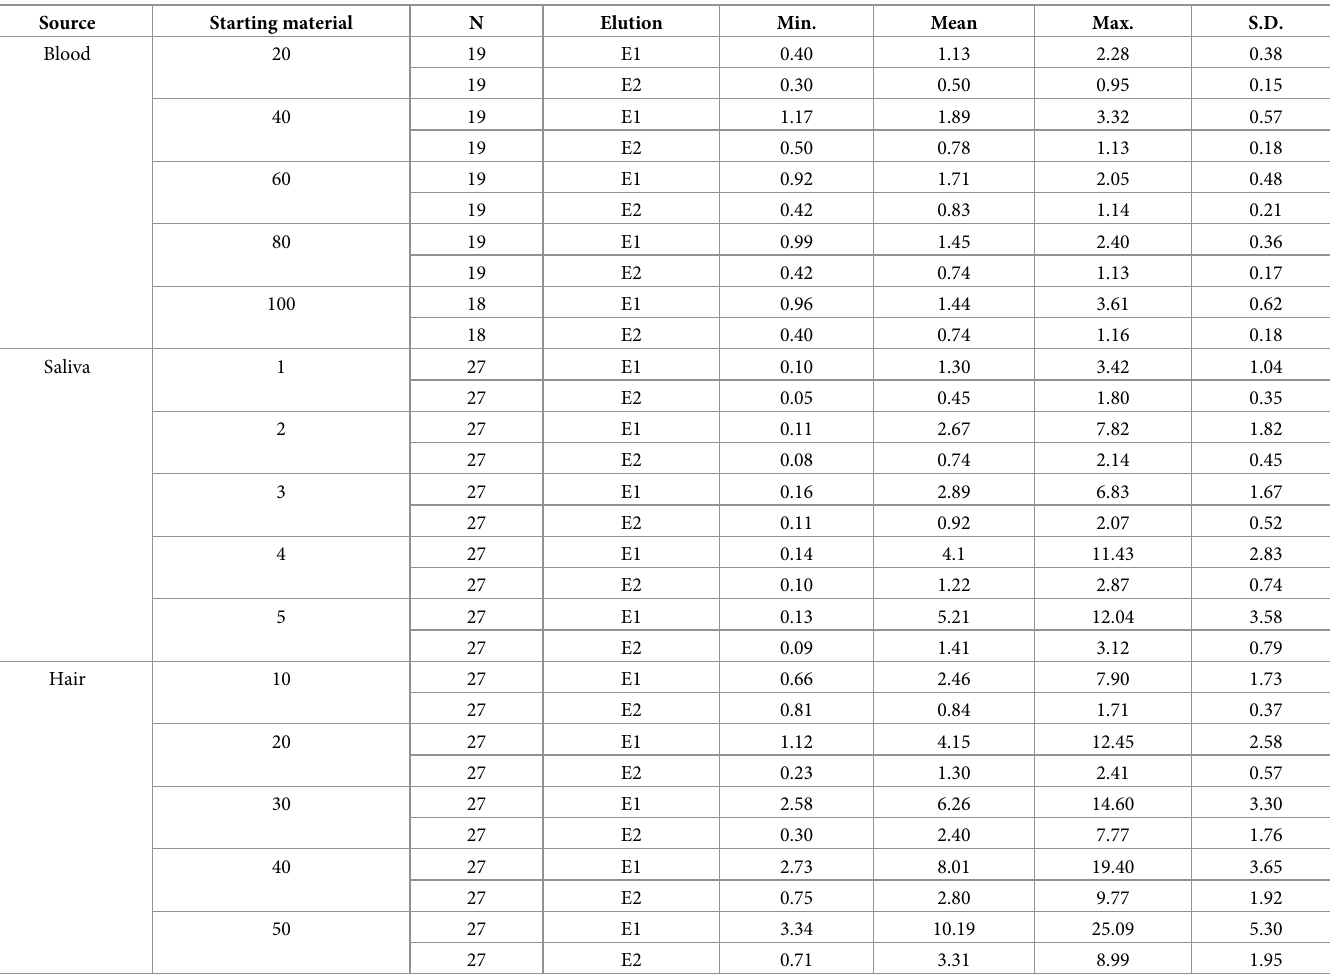
especially for the extractions that used 40 and 50 follicles (S4D and S4E Fig). Increased tail- hair follicle quantities were associated higher extracted DNA band intensities (S4 Fig), Imply- ing increased DNA amount. No differences in the quality of DNA were detected between the three replicated extractions of each individual, among individual camels, or among breeds (S4 Fig). The different numbers of tail-hair follicles resulted in a 0.66–25.08 μ g range in extracted DNA amount and a range of 260/280 ratios of 1.36–2.34 (Fig 2C). The 10, 20, 30, 40, 50 hair follicles provided, on average, 2.46, 4.15, 6.26, 8.01, and 10.19 μ g of extracted DNA, respec- tively, with an average 260/280 ratio of 1.99 (Table 1). The second elution on average con- tained ~37.7% of the amount of DNA in the first elution (Table 1; S2 Fig). When all the data were considered together, the nonparametric linear regression analysis indicates that starting tail-hair DNA sample quantity (10, 20, 30, 40, 50 hair follicles)